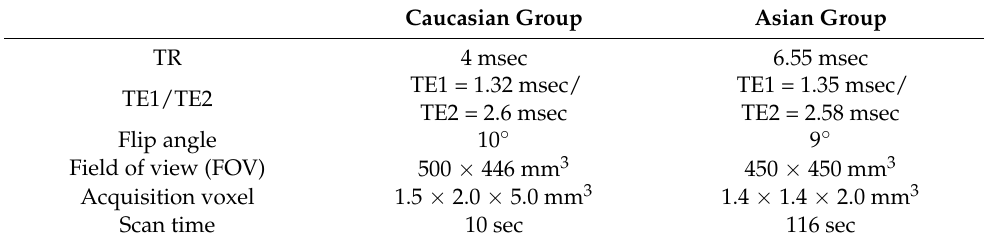
Table 1. MRI sequence parameters used in both